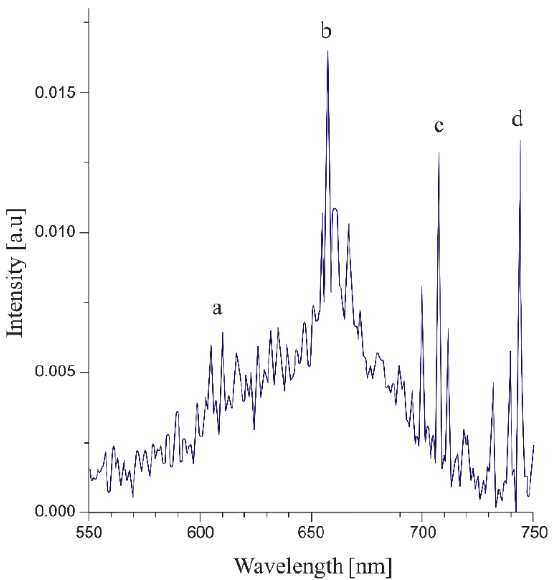
Figure 7. Photoluminescence spectrum of ZnSe co-doped with Eu 3+ /Yb 3+ at 20 K. a is the emission line of pure ZnSe and b, c, d are the new emission lines due to dopants.